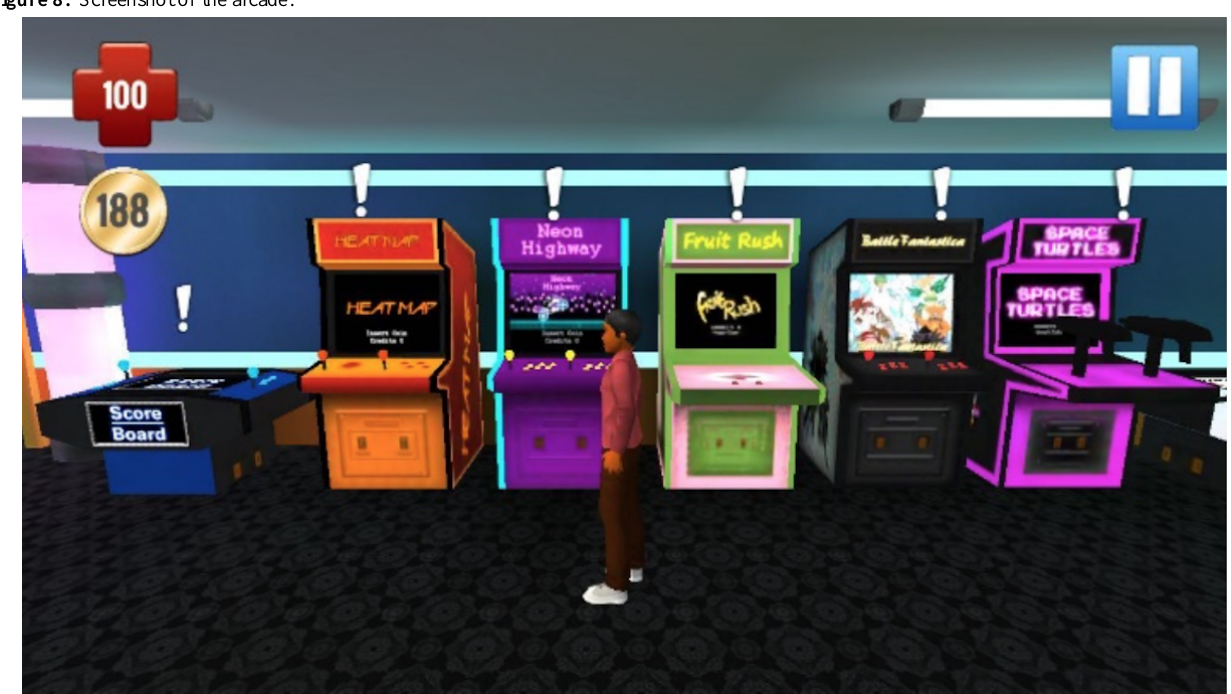
Figure 8. Screenshot of the